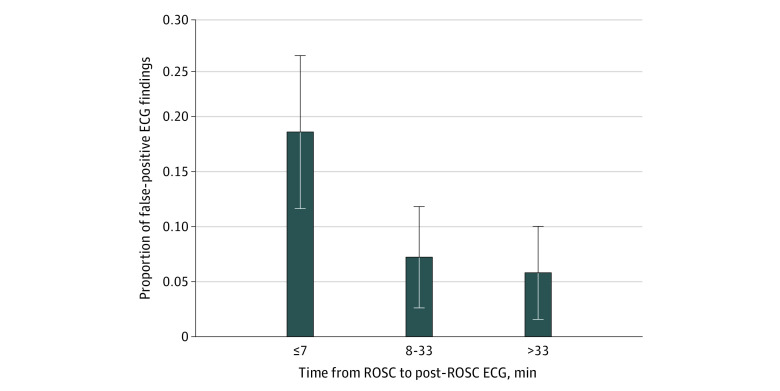
Percentage of False-Positive Electrocardiography (ECG) Findings for ST-Segment Elevation Myocardial Infarction (STEMI) in the Population in Whom a Percutaneous Coronary Angioplasty (PTCA) Was Not PerformedThe population was divided into 3 tertiles of time from return of spontaneous circulation (ROSC) to post-ROSC ECG acquisition (≤7 min, 8-33 min, and >33 min). In the logistic regression model, P < .001. Error bars indicate 95% CIs.